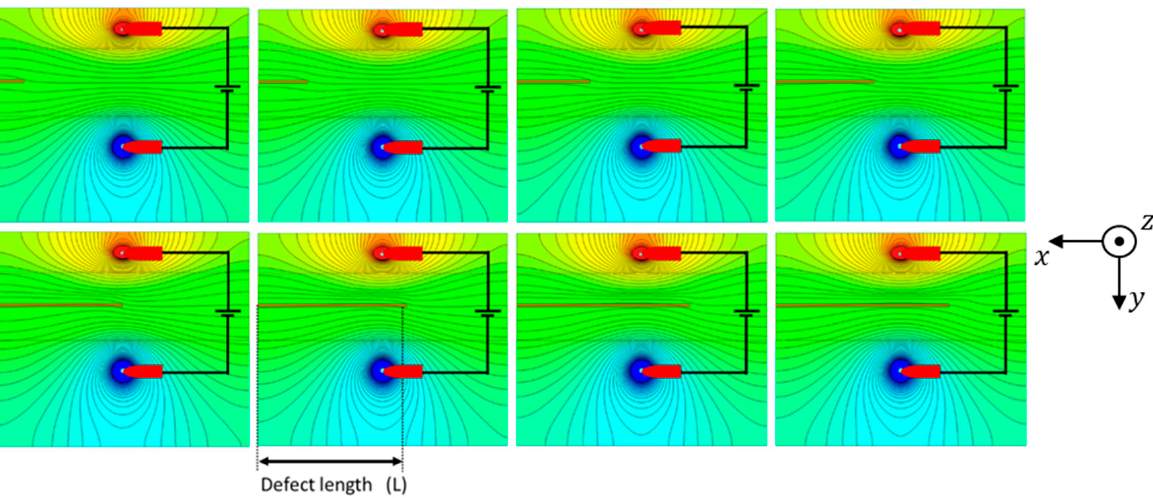
Figure 7. Electric equipotential lines from the top of the weld bead for an increasing defect in the X direction.